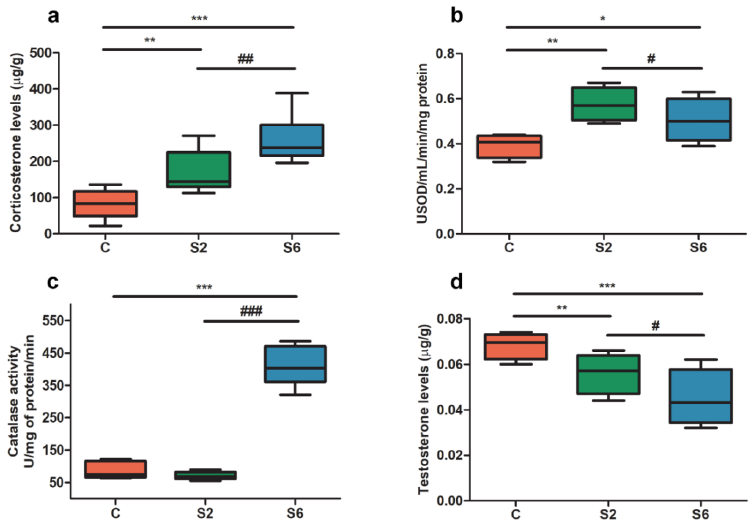
Figure 2. Repetitive restraint stress imbalanced the steroids levels and increased the activity of the antioxidant enzymes; ( a ) After repeated exposure to restraint stress, CA3 corticosterone (CS) levels were progressively increased ( p < 0.01), whereas ( d ) testosterone (TS) concentrations were proportionally decreased after 2 days ( p < 0.01) and 6 days ( p < 0.001) of restraining; ( b ) SOD was increased after 2 ( p < 0.01) and 6 ( p < 0.05) days of stress, while ( c ) CAT was increased ~5 fold ( p < 0.001) only after 6 days of repetitive stress exposure. The bottom and top of the box are the first and third quartiles and the whiskers above and below the box indicate the 95th and 5th percentiles. The median is indicated as a horizontal line. The experimental groups were distributed on the X axis. The Y axis was used to expose the measuring unit for the parameters. Statistical significance between S2 and S6 was noted with # (# p < 0.05; ## p < 0.01; ### p < 0.001), whereas the comparison to Control was annotated with * (* p < 0.05; ** p < 0.01; *** p < 0.001). F values: 2.75 (CS), 2.25 (TS), 9.05 (SOD), 86.24